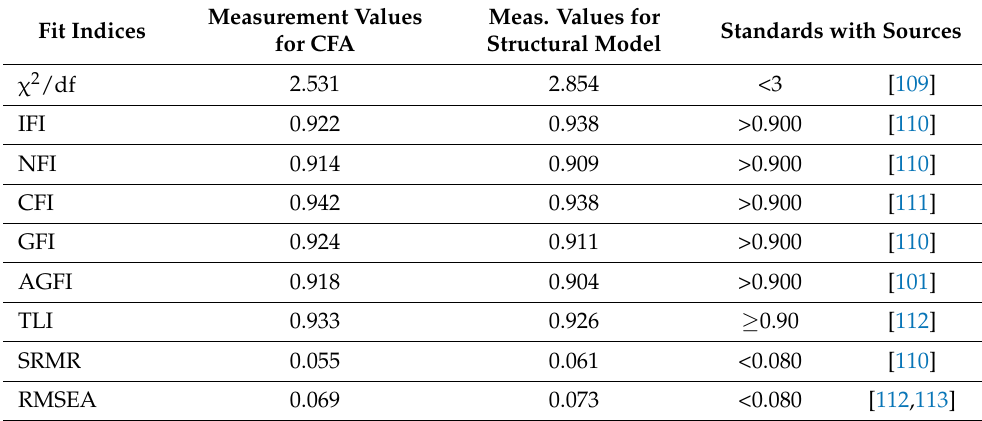
Table 7. Results of the CFA and structural model with